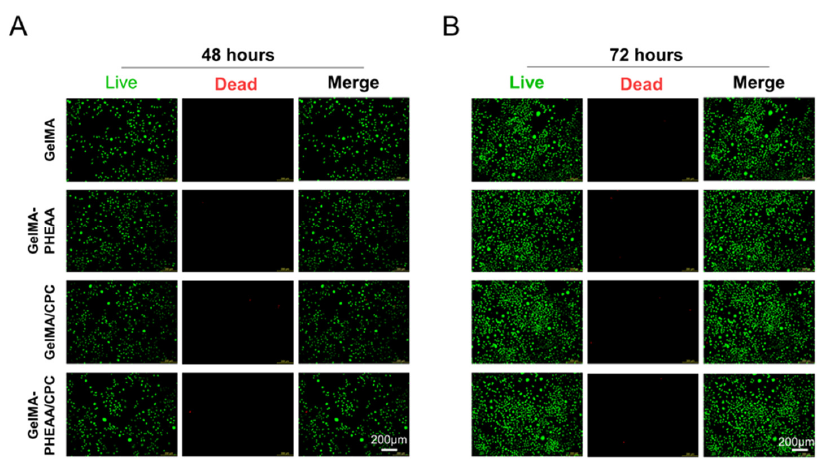
Figure 4. In vitro cell biocompatibility of GelMA-PHEAA/CPC hydrogels. Representative live/dead staining images of L929 cells for GelMA, GelMA-PHEAA, GelMA/CPC, and GelMA-PHEAA/CPC on 48 ( A ) and 72 h ( B ).